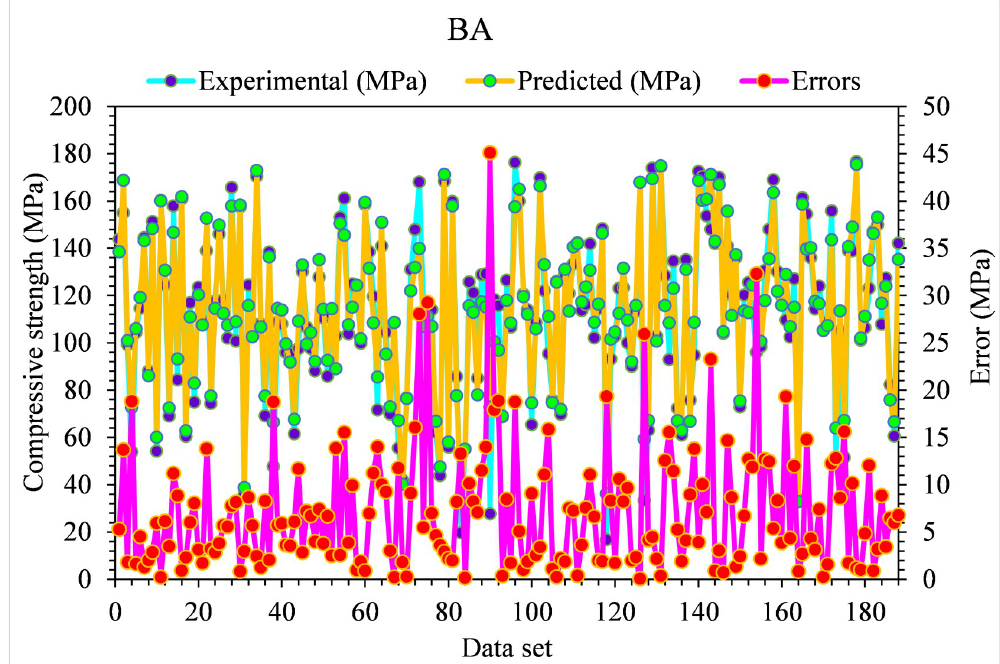
Fig 15. BA predicted and experimental error values–UHPC compressive strength.